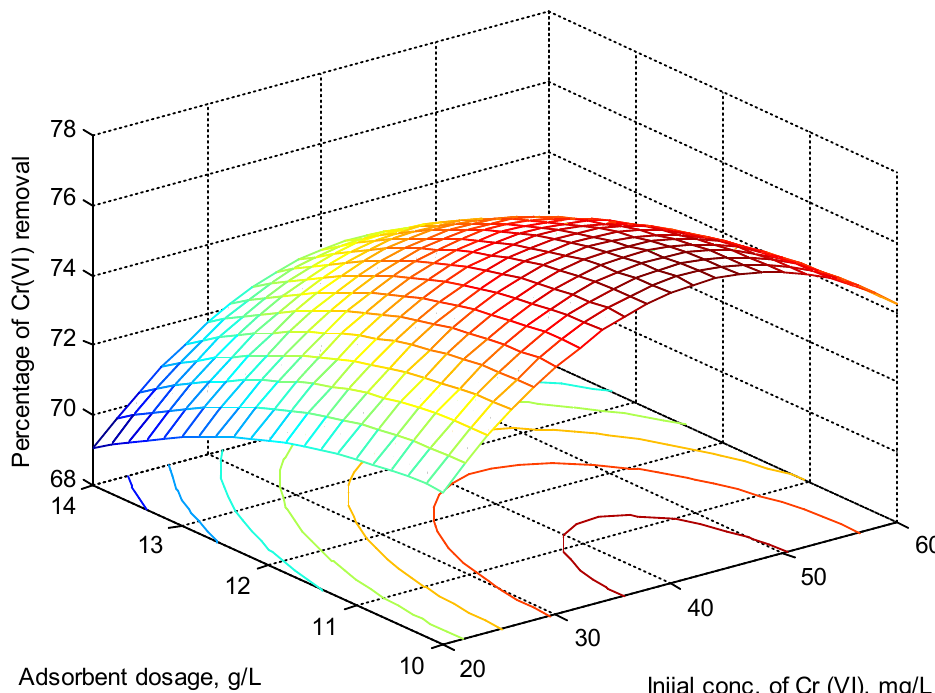
Figure 7. Effect of interaction between mixed adsorbent dosage and initial concentration of Cr (VI) on removal of Cr (VI) (pH value at